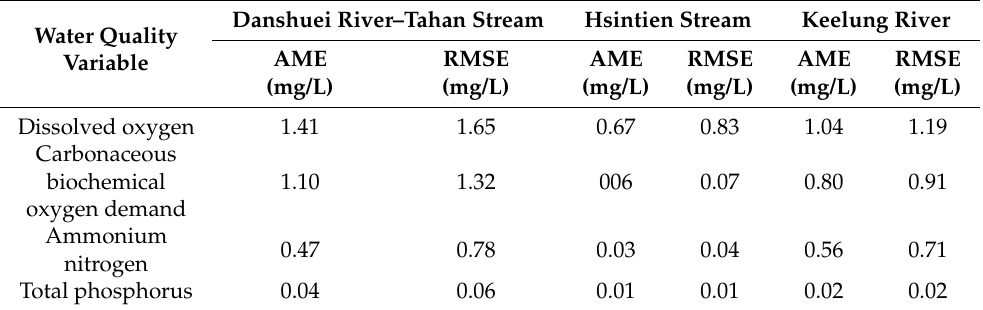
Table 5. Statistical error between simulated and measured water quality state variables on 5 September 2011. Water Quality